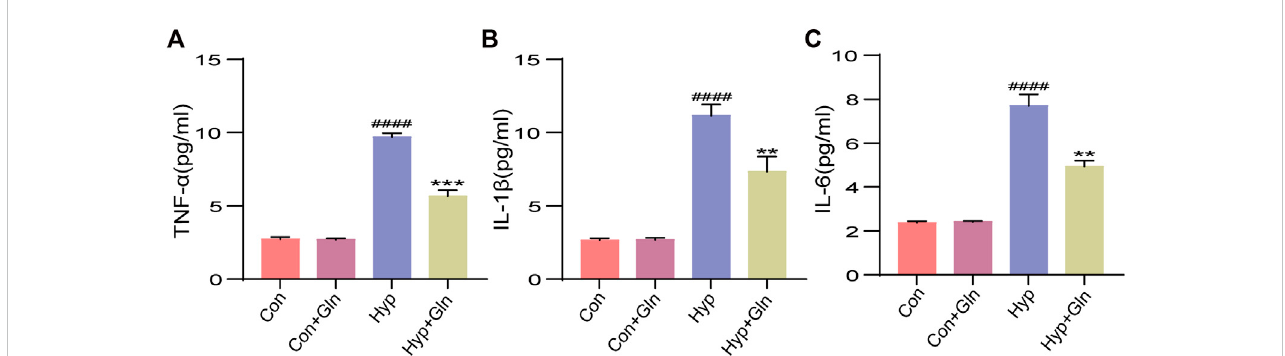
FIGURE 5 Gln inhibits in fl ammation caused by hyperoxia. (A) TNF- α content in hippocampus. Con (2.73 ± 0.84), Con + Gln (2.69 ± 0.41), Hyp (9.70 ± 0.15), Hyp + Gln(5.67± 0.22). (B) IL-1 β contentinhippocampus.Con(2.65±0.08),Con+Gln(2.68 ±0.08),Hyp(11.16± 0.44), Hyp+Gln (7.33± 0.60). (C) IL-6content in hippocampus. Con (2.38 ± 0.05), Con + Gln (2.42 ± 0.02), Hyp (7.71 ± 0.30), Hyp + Gln (4.94 ± 0.16) ( n = 3). #### p < 0.0001 vs. the Con, ** p < 0.01, *** p < 0.001 vs. the Hyp. p < 0.05 was considered statistically signi fi